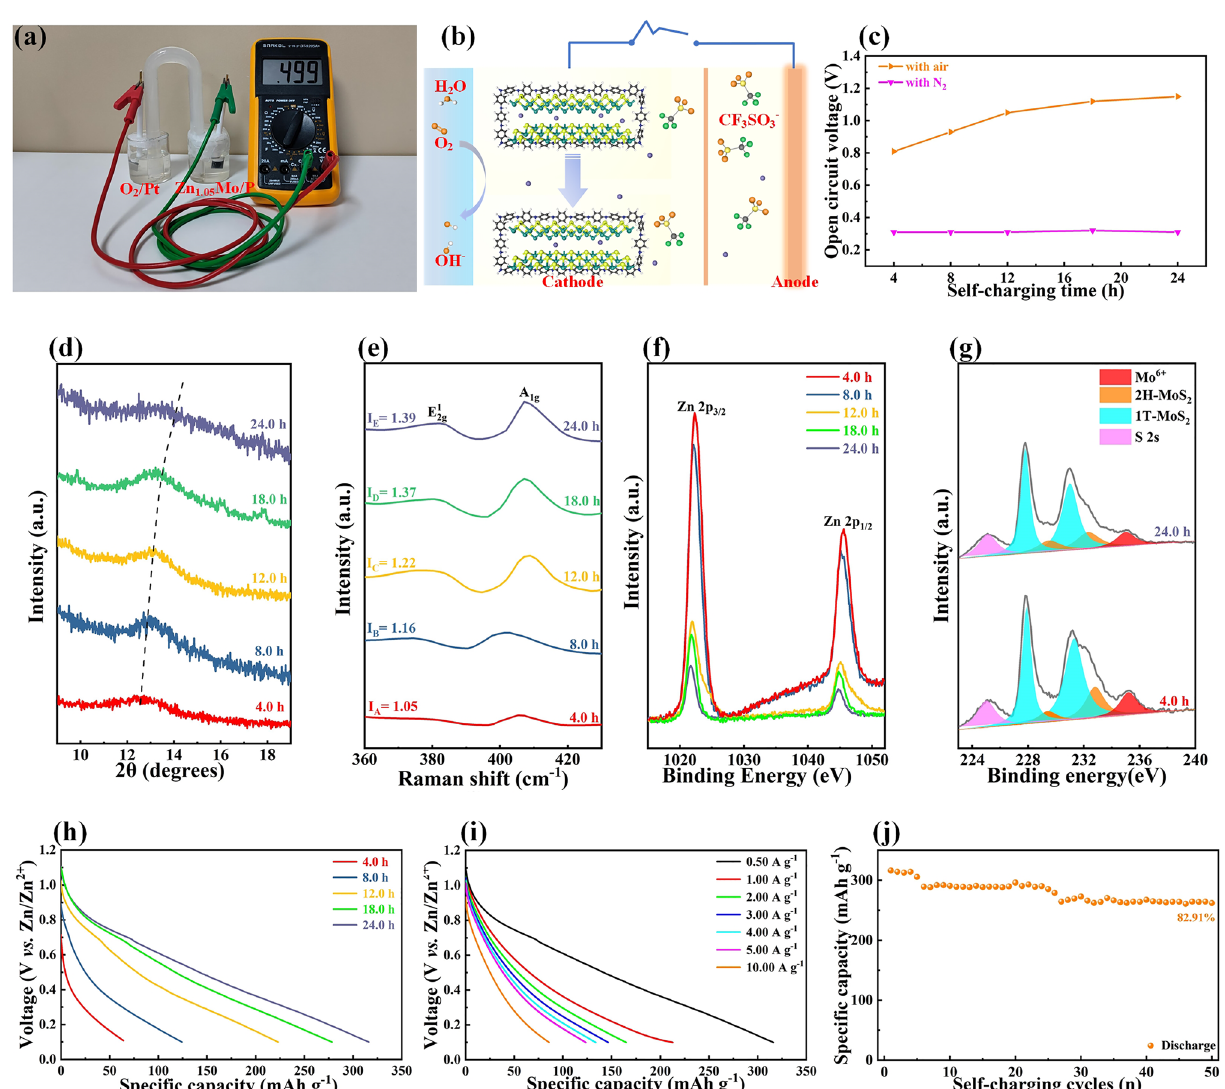
Fig. 5 Mechanism of the redox reaction between Zn 0.85 Mo/P and O 2 and air recharging/galvanostatic discharging behavior of Zn//Zn 0.85− x Mo/P batteries. a Optical image of the designed galvanic cell. b Working mechanism of air-rechargeable ZIBs. c Effect of the oxidation time on OCV of Zn//Zn 0.85− x Mo/P batteries. d XRD patterns, e Raman patterns, XPS spectra of f Zn and g Mo of Zn//Zn 0.85− x Mo/P batteries after different air- recharging time. h Galvanostatic discharging curves of Zn//Zn 0.85− x Mo/P batteries after different air-recharging time. i Galvanostatic discharging curves of Zn//Zn 0.85− x Mo/P batteries at different current density after 24.0-h air recharging. j Air recharging/galvanostatic discharging life of Zn//Zn 0.85− x MoS